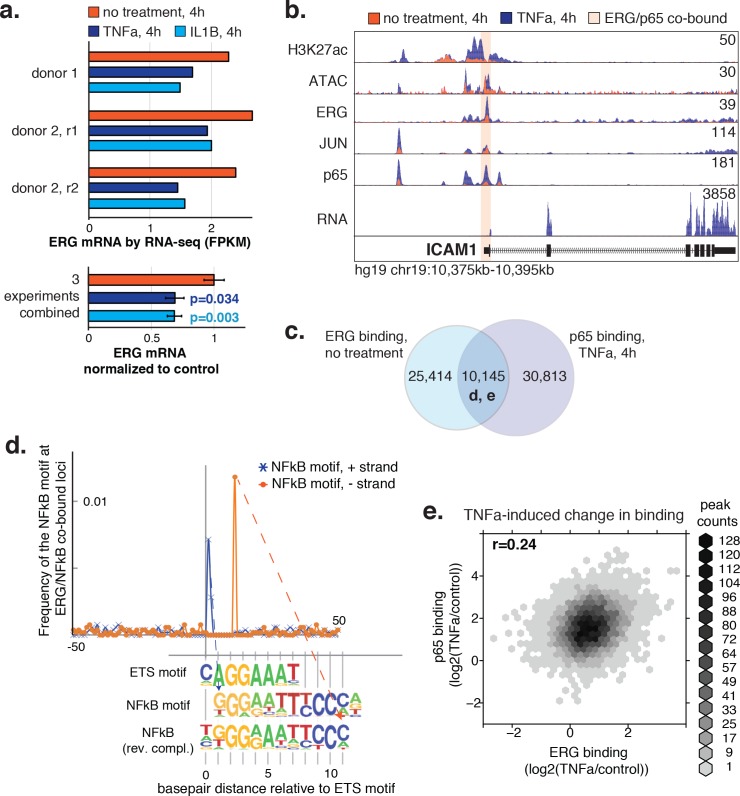
ERG and p65 co-bind loci with a distinctive ETS/NFκB motif.(a) ERG mRNA was measured in HAECs by RNA-seq in three independent experiments in media lacking (no treatment) or containing 2 ng/µl TNFα or 10 ng/µl IL1β for 4 hr. (b) ATAC-seq, RNA-seq, and ChIP-seq data for H3K27ac, ERG, JUN, and p65 are shown at the ICAM1 locus in no treatment and TNFα conditions. Normalized tag counts are shown on the y axis. (c) A Venn diagram showing the number of loci bound by ERG and/or p65. (d) Distance of NFκB motifs relative to the central ETS motif (x-axis = 0) at 5326 loci co-bound by ERG and p65 is shown. Note that the remaining ~ 5000 co-bound loci that did not contain a canonical ETS motif were omitted from this analysis. (e) The log2 ratio of normalized TF binding was calculated for ERG and p65 at all co-bound loci between TNFα-treated and the no treatment control. The density of peaks per area is plotted via the hexbin R package.